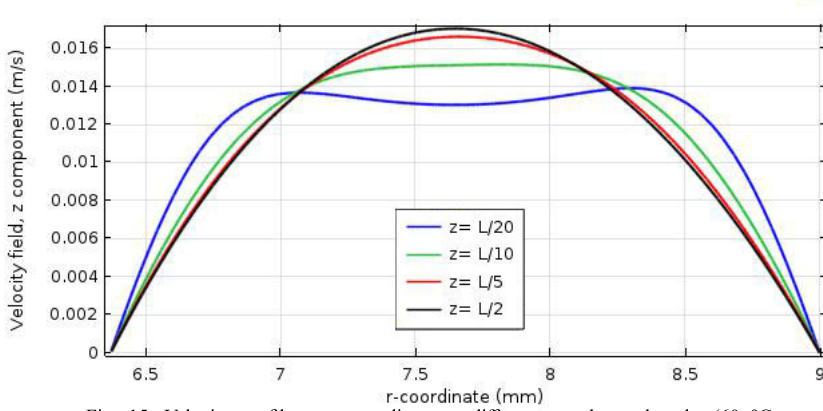
Fig. 15: Velocity profile vs. r-coordinate at different membrane lengths (60 °C temperature, 3 l/min feed flow rate and 1 bar pressure)